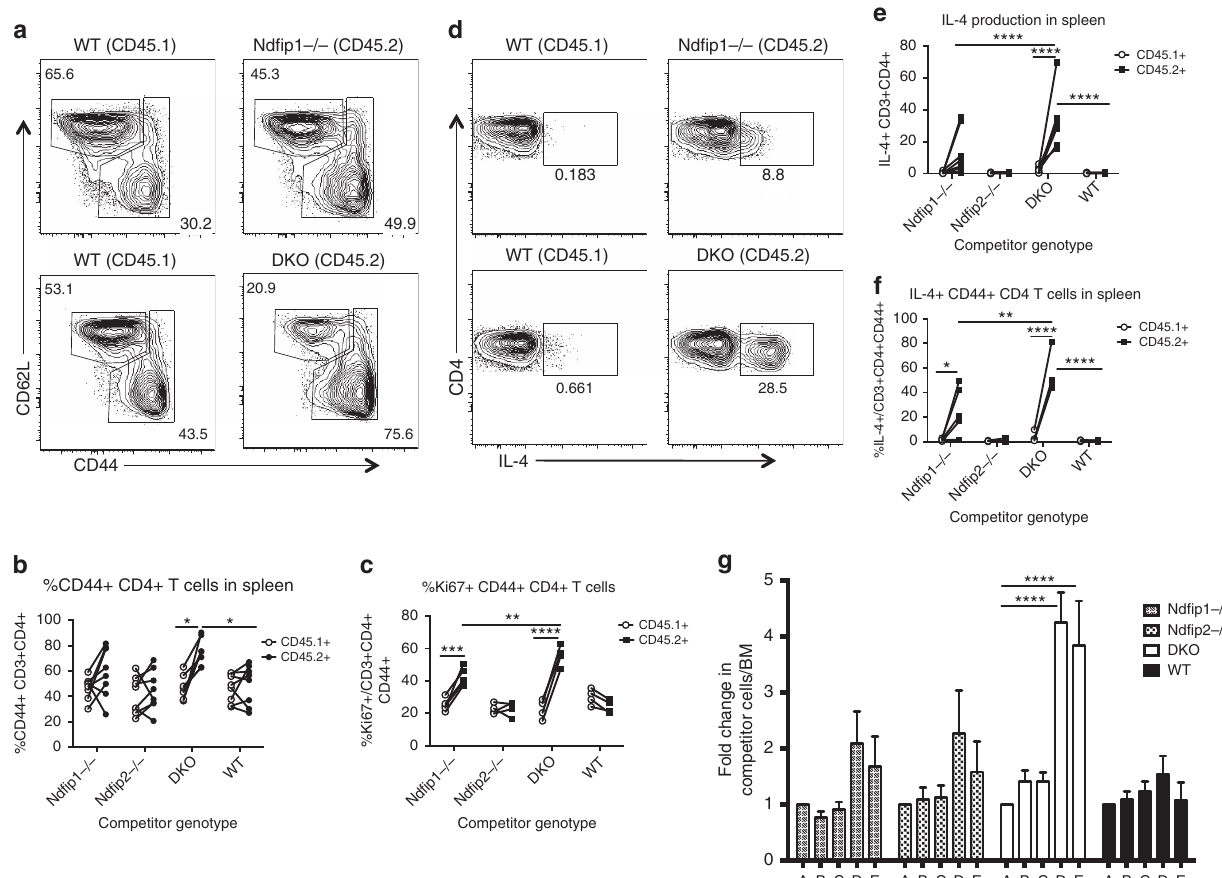
Figure 3 | Ndfip deficiency causes intrinsic CD4 þ effector T-cell expansion. ( a – g ) Mixed foetal liver chimeras using CD45.2 WT, Ndfip1 (cid:2) / (cid:2) , Ndfip2 (cid:2) / (cid:2) or Ndfip1/Ndfip2 DKO foetal liver were analysed 6 weeks following reconstitution. ( a ) Representative CD44 and CD62L staining of splenic CD4 þ T cells from Ndfip1 (cid:2) / (cid:2) mixed chimera (top) and DKO mixed chimera (bottom), previously gated on live, singlet CD3 þ CD4 þ CD45.1 or CD45.2 þ cells. ( b , c ) Flow cytometry analysis of CD45.1 þ and CD45.2 þ splenic T cells from chimeras showing ( b ) percentages of CD44 þ cells and ( c ) percentages of CD44 þ that are Ki67 þ . ( d – f ) Ex vivo stimulated splenocytes were stained for IL-4. ( d ) Representative flow plots of IL-4 þ CD4 þ T cells, ( e ) combined data from d , ( f ) percentages of CD44 þ CD4 T cells that are IL-4 þ . ( g ) Percentages of CD45.2 cells among various T-cell subsets, normalized for reconstitution, as determined by the ratio for CD45.2:CD45.1 IgM þ B220 þ B cells in the bone marrow. Compartments analysed are as follows: A ¼ IgM þ B cells in bone marrow, B ¼ double positive thymocytes, C ¼ single positive CD4 þ thymocytes, D ¼ CD44 þ CD4 þ Tcells in spleen, E ¼ CD44 þ CD4 þ T cells in lung. Data shown in b and e were pooled from two experiments, 7–8 chimeras per group; ( c , f , g ) have 4–5 chimeras per group. Quantifications are average ± s.e.m. P values calculated by two-way ANOVA ( b , c , e , f ) or repeated measures one-way ANOVA ( g ), with